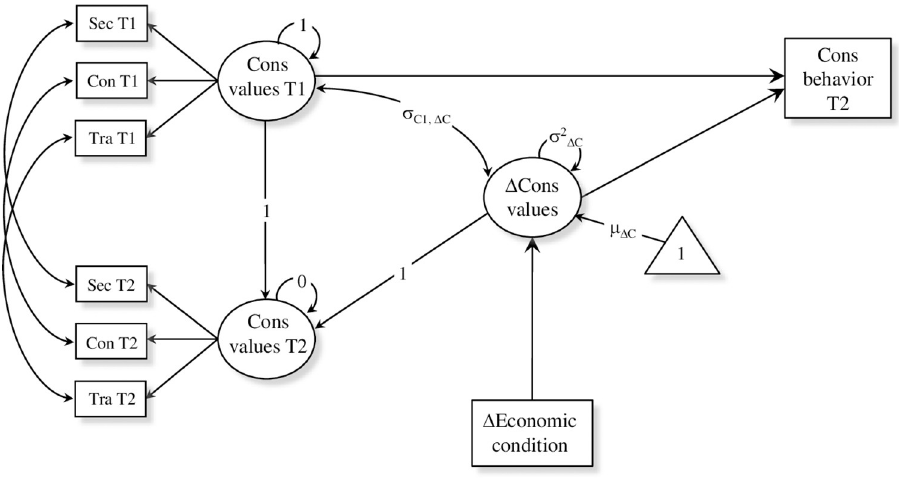
Fig 3. Path diagram of the conditional LCS model for conservation values. Sec = Security; Con = Conformity; Tra = Tradition; Cons = Conservation.